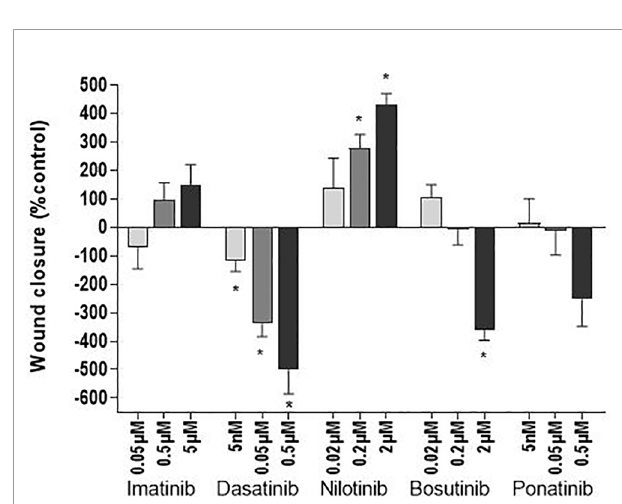
FIGURE 5 | Dasatinib and bosutinib reduce wound closure. HUVEC migration was assessed by a scratch test after exposure of the cells to BCR- ABL TKIs for 24 h in 10% FBS media to avoid cell death due to serum-free conditions. Histograms represent wound closure 6 h after the scratch. Bars represent the means ± SEM of n = 6 of three independent experiments (N = 3). Differences between conditions were tested using the Wilcoxon signed rank test that compared each TKI condition versus control. *p <